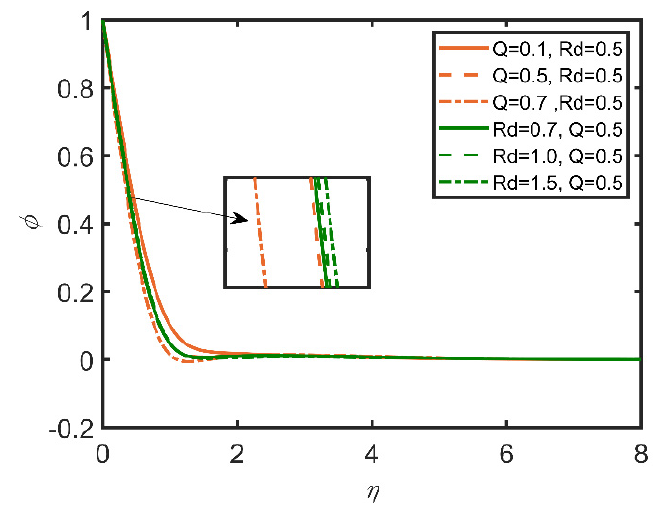
Figure 18. Comparison for concentration profile against 𝜂 .